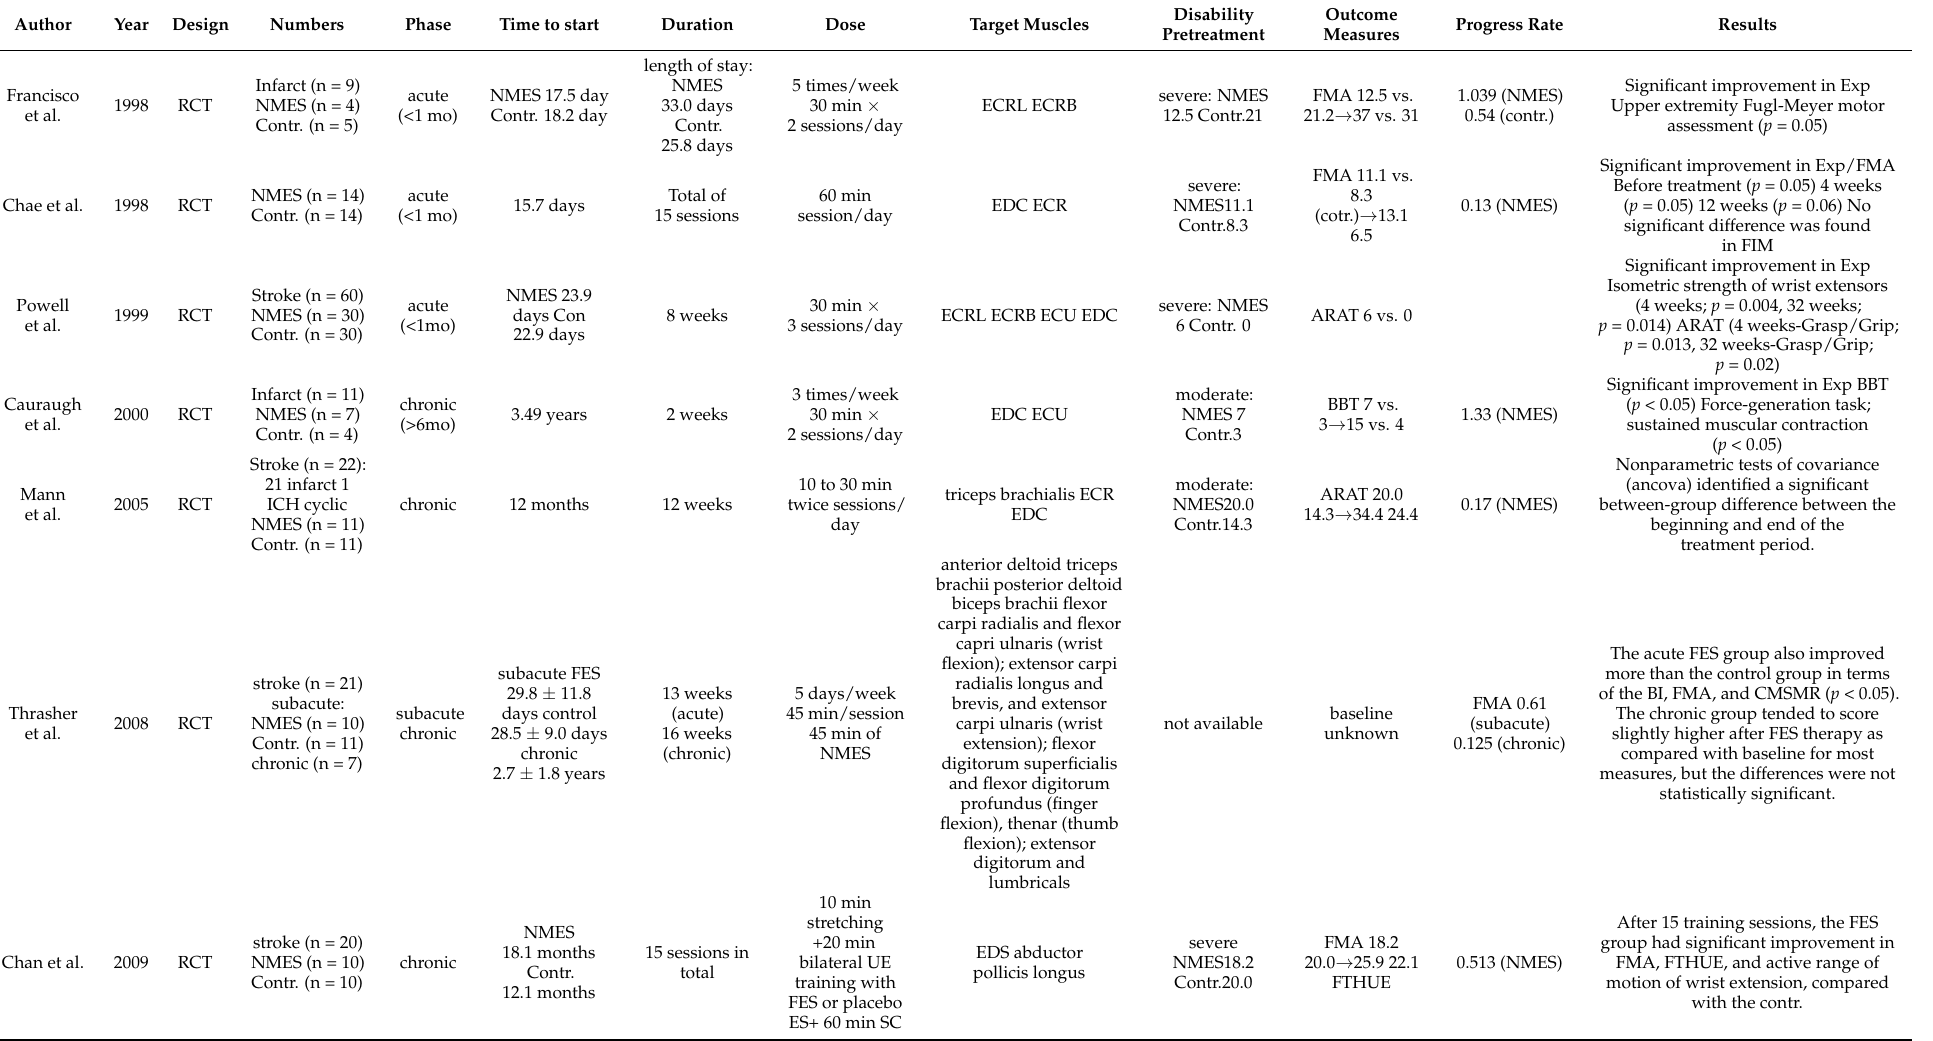
Table 1. Summary of the included NMES